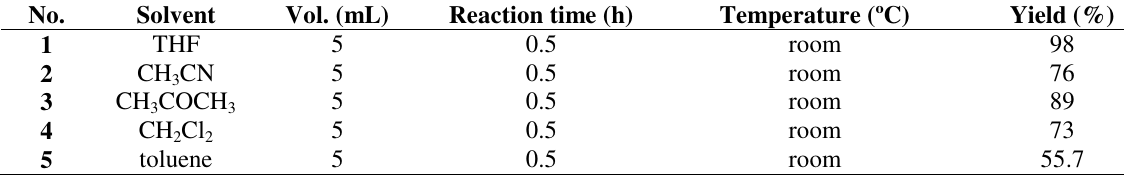
Table 2. Role of different solvents for the synthesis of 3e